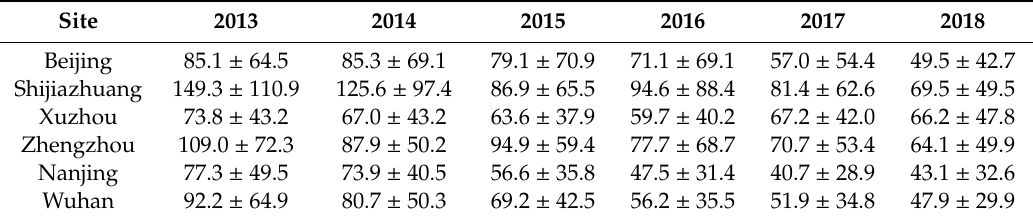
Figure 2. Annual mean of 24-h PM 2.5 over mainland of China in 2013–2018. Table 1. Variations in annual mean PM 2.5 concentration ( µ g / m 3 ) and corresponding variance in typical megacities of eastern China.